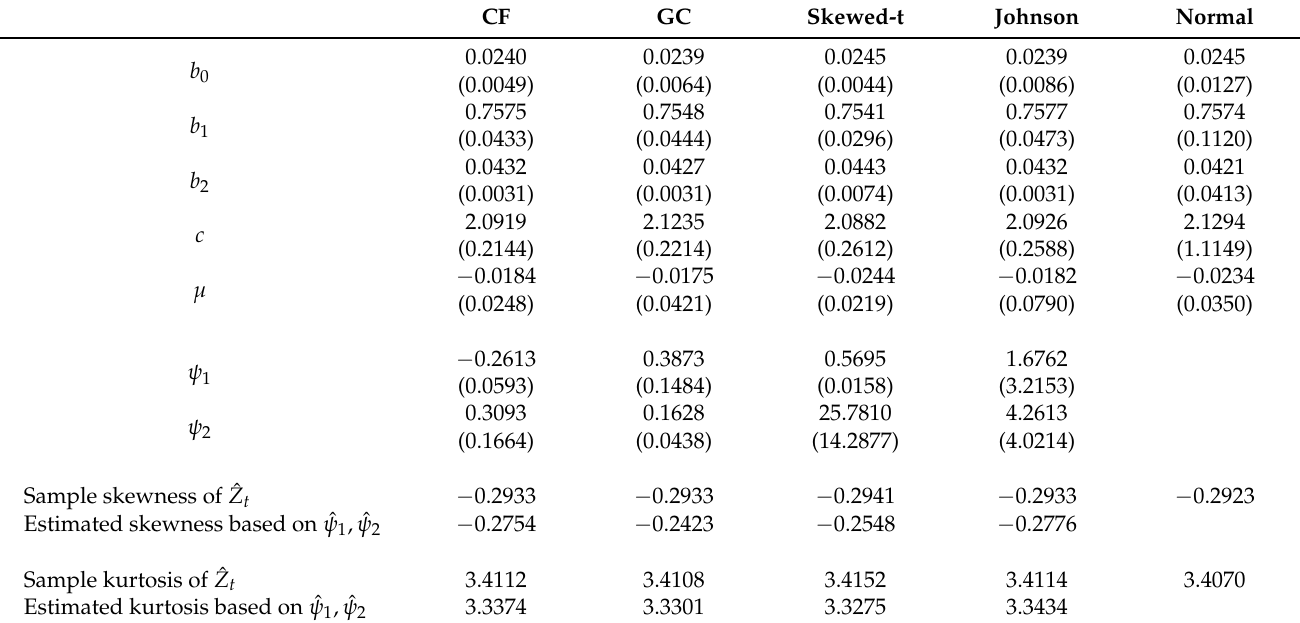
Table 2. Parameter Estimates of Euro Stoxx 50 (In-Sample Period